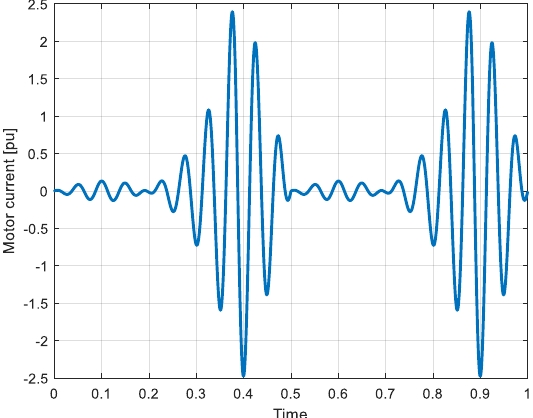
Figure 20. Current in one phase of the motor (p.u).